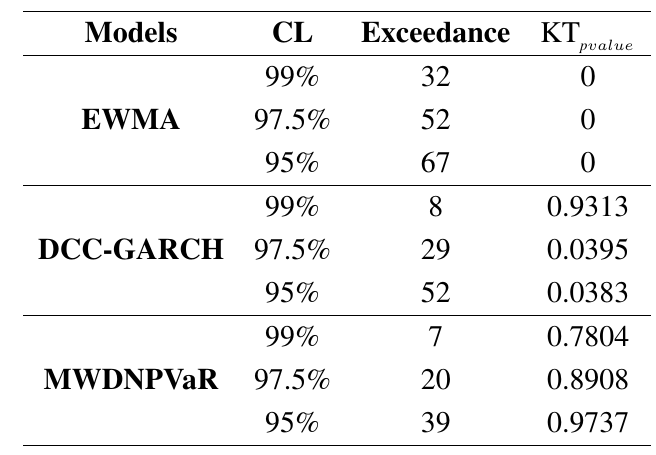
Table 4. Reliability comparison of different